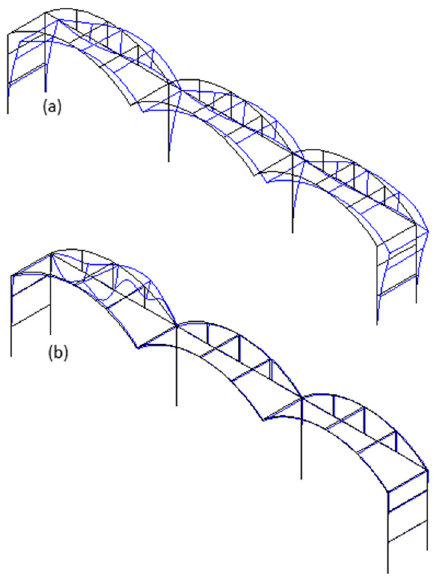
Figure 22. Buckling mode for ( a ) load combination 7 based on wind loads according to EN 13031-1 (2001) (general type) and ( b ) load combination 7CFD based on wind loads calculated through CFD (first arch, up-down displacement type).